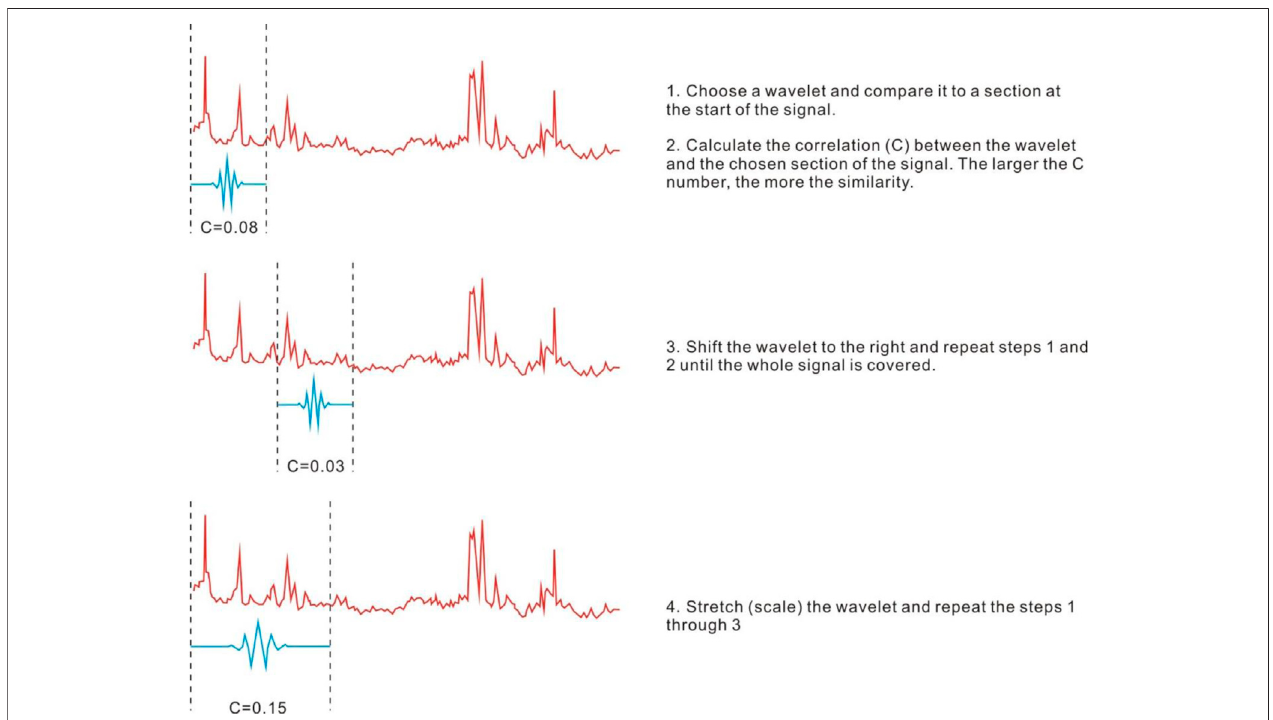
FIGURE 13 | Flow chart of continuous wavelet transform (CWT) (Kadkhodaie, 2017).